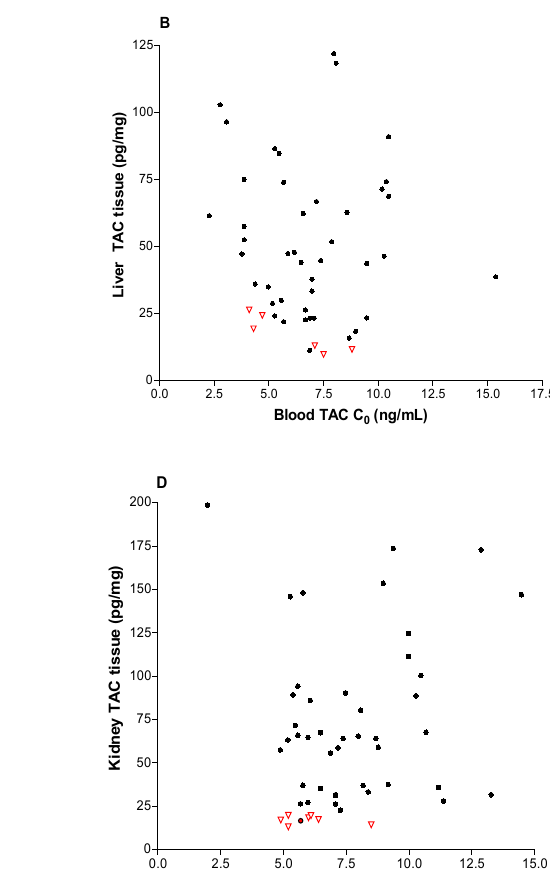
100 transplant patients.